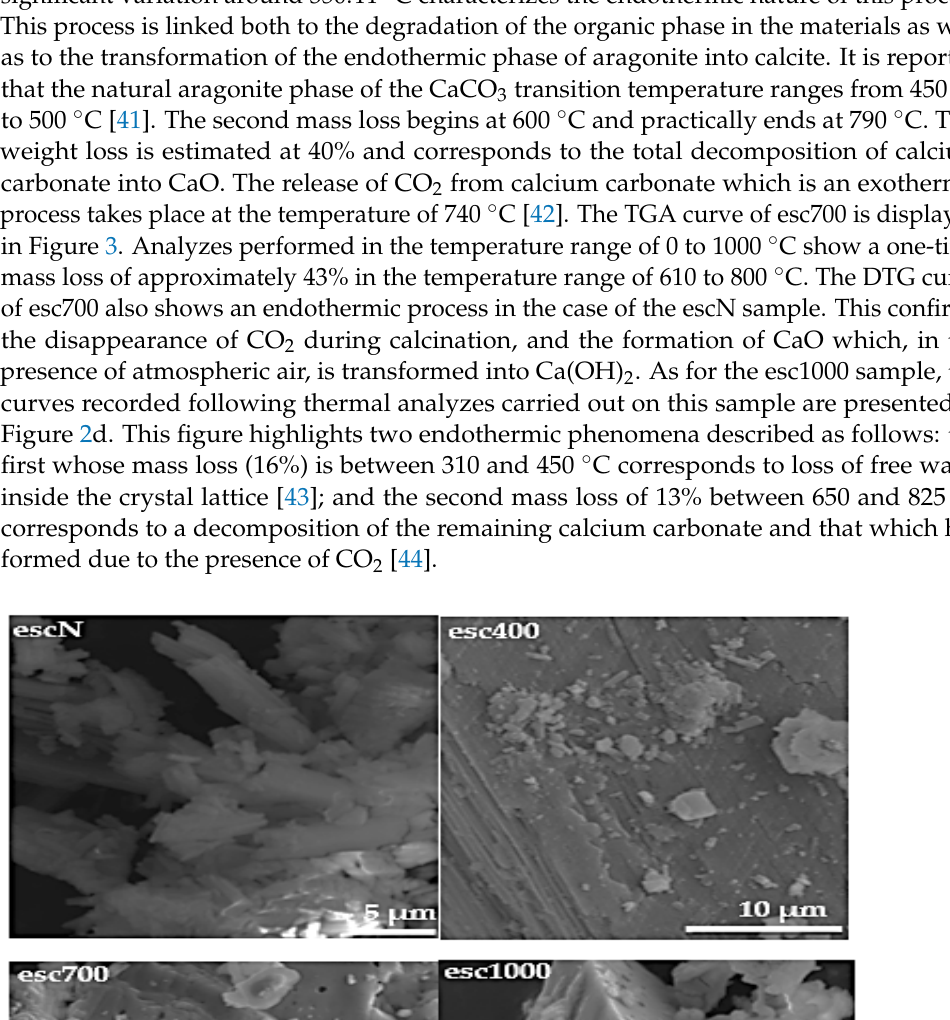
Figure 3. SEM image of escN, esc400, esc700 and esc1000. The SEM images of the materials escN, esc400, esc700 and esc1000 are displayed